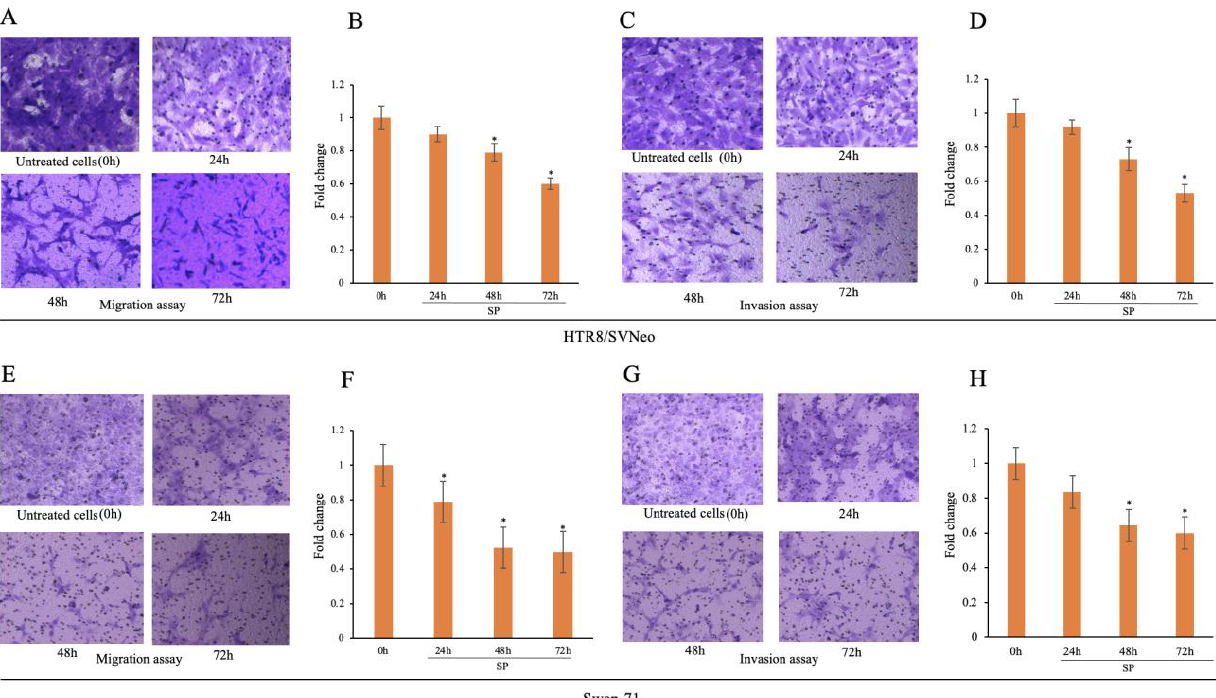
Figure 3. Effect of palmitic acid on migration and invasion in HTR8/SVneo and Swan-71 cells. Migration ( A ) and invasion ( C ) in HTR8/SVneo cells after exposure to palmitic acid for 0 to 72 h and migration ( E ) and invasion ( G ) in Swan-71 cells after the same exposures. Images were captured from the underside of the transwell inserts. Quantification ( B , D , F , H ) was carried out by counting the migrated or invaded cells using a hemocytometer. Mean values were obtained from three independent experiments and error bars indicate SD. * p < 0.05 compared to